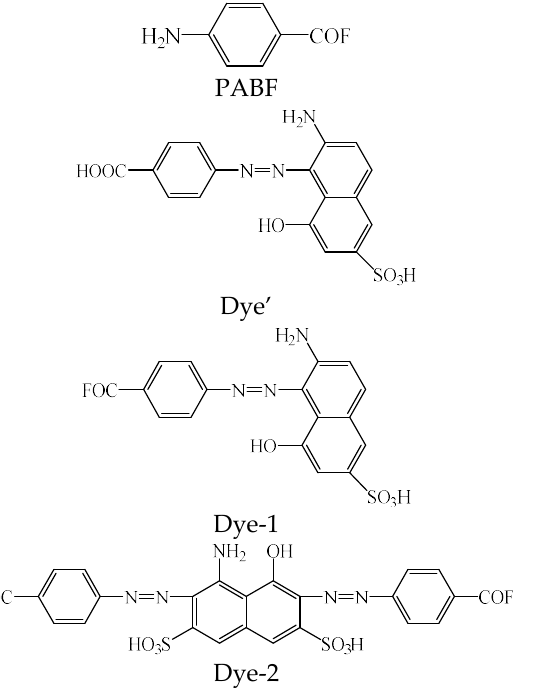
8 of 12 Table 3. Washing fastness, rubbing fastness, and light fastness of dyed cotton fabrics.